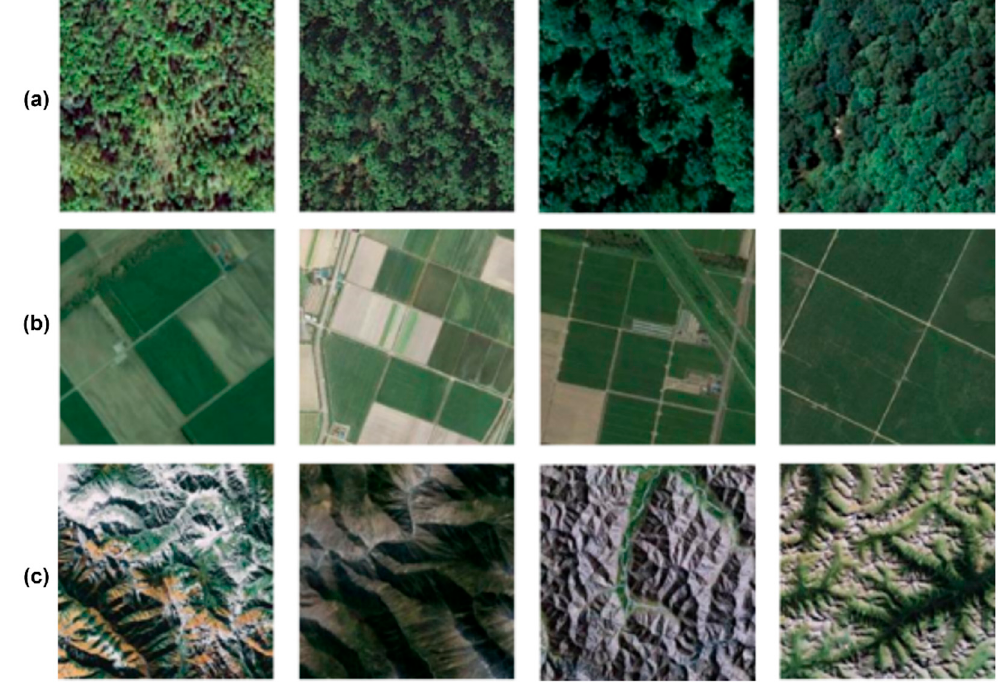
Figure 4. Selected landscape categories from the AID dataset. Row ( a ) forest landscape, row ( b ) farm landscape, and row ( c ) mountain landscape.